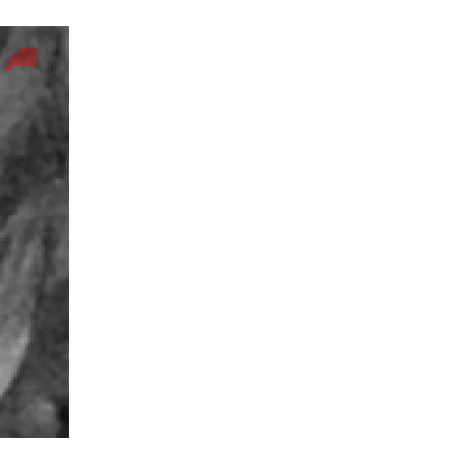
Figure 4. Periapical lesion localization mask at tooth